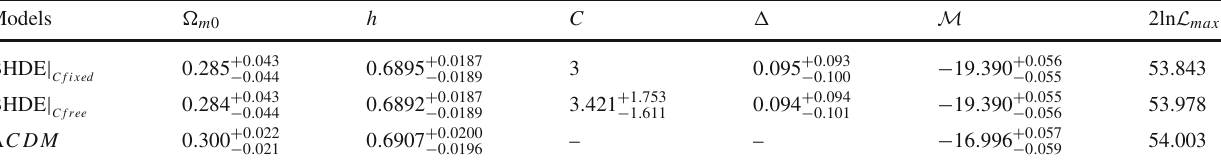
Table 1 Observational constraints on the parameters of Barrow holographic dark energy (BHDE), and the corresponding L max , using SN Ia and CC datasets Models